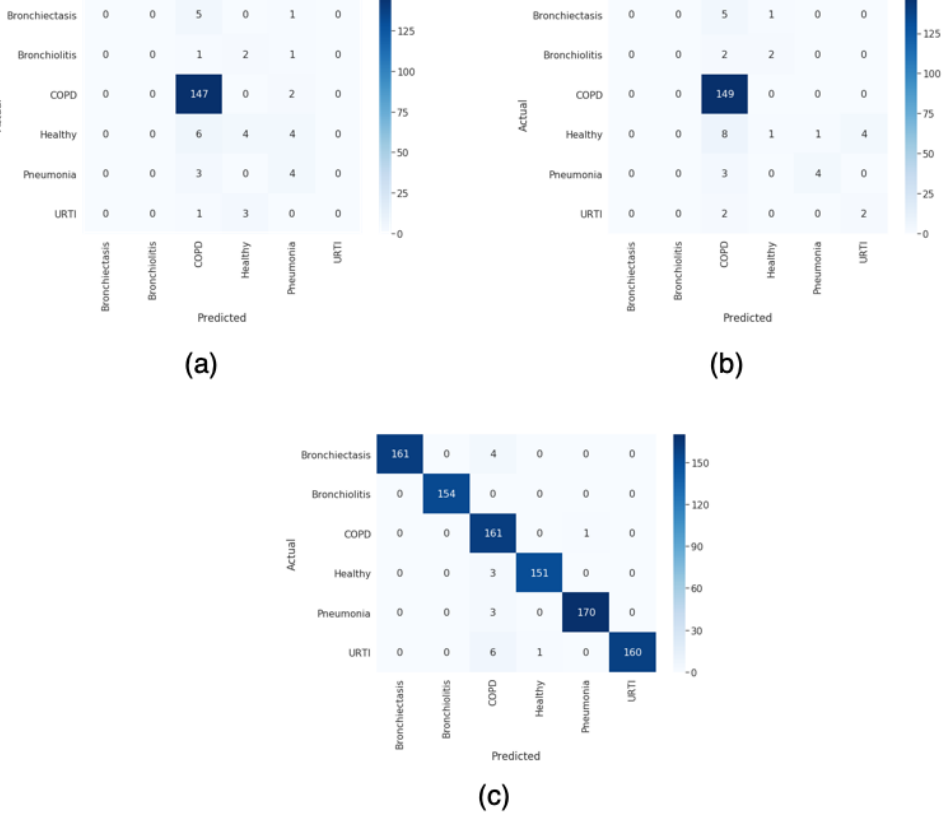
Figure 9. ( a ) Confusion matrix of the unbalanced dataset. ( b ) Confusion matrix of the unbalanced dataset with weights in the training. ( c ) Confusion matrix of the balanced dataset using our proposed scheme with